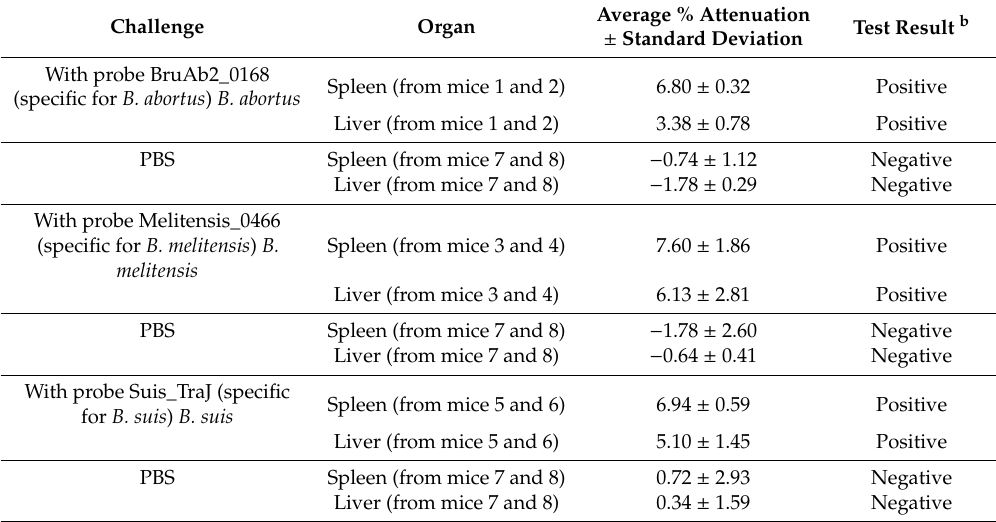
Table 4. Percent NOFS a light attenuation from spleen and liver extracts from mice infected with Brucella spp. Average % Attenuation b Challenge Organ ± Standard Deviation Test Result With probe BruAb2_0168 Spleen (from mice 1 and 2) 6.80 ± 0.32 Positive (specific for B. abortus ) B. abortus Liver (from mice 1 and 2) 3.38 ± 0.78 Positive PBS Spleen (from mice 7 and 8) − 0.74 ± 1.12 Negative Liver (from mice 7 and 8) − 1.78 ± 0.29 Negative With probe Melitensis_0466 (specific for B. melitensis ) B. Spleen (from mice 3 and 4) 7.60 ± 1.86 Positive melitensis Liver (from mice 3 and 4) 6.13 ± 2.81 Positive PBS Spleen (from mice 7 and 8) − 1.78 ± 2.60 Liver (from mice 7 and 8) − 0.64 ± 0.41 Negative With probe Suis_TraJ (specific Spleen (from mice 5 and 6) 6.94 ± 0.59 for B. suis ) B. suis PBS Spleen (from mice 7 and